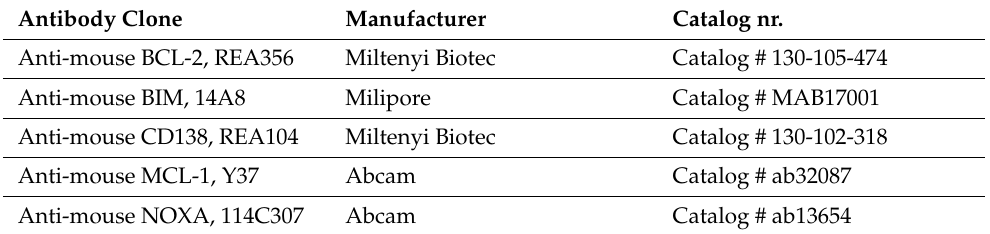
Table 1. Antibodies used for flow-cytometric measurement of apoptosis